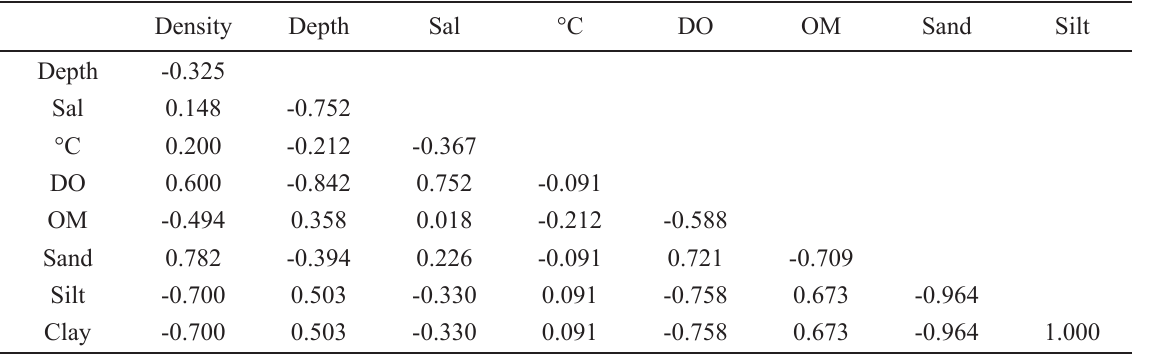
Table 8. Spearman’s correlation coefficient between density of Spinodiosaccus primus gen. et sp. nov. and environmental variables. Sal = salinity; °C = temperature; DO = dissolved oxygen; OM = organic matter